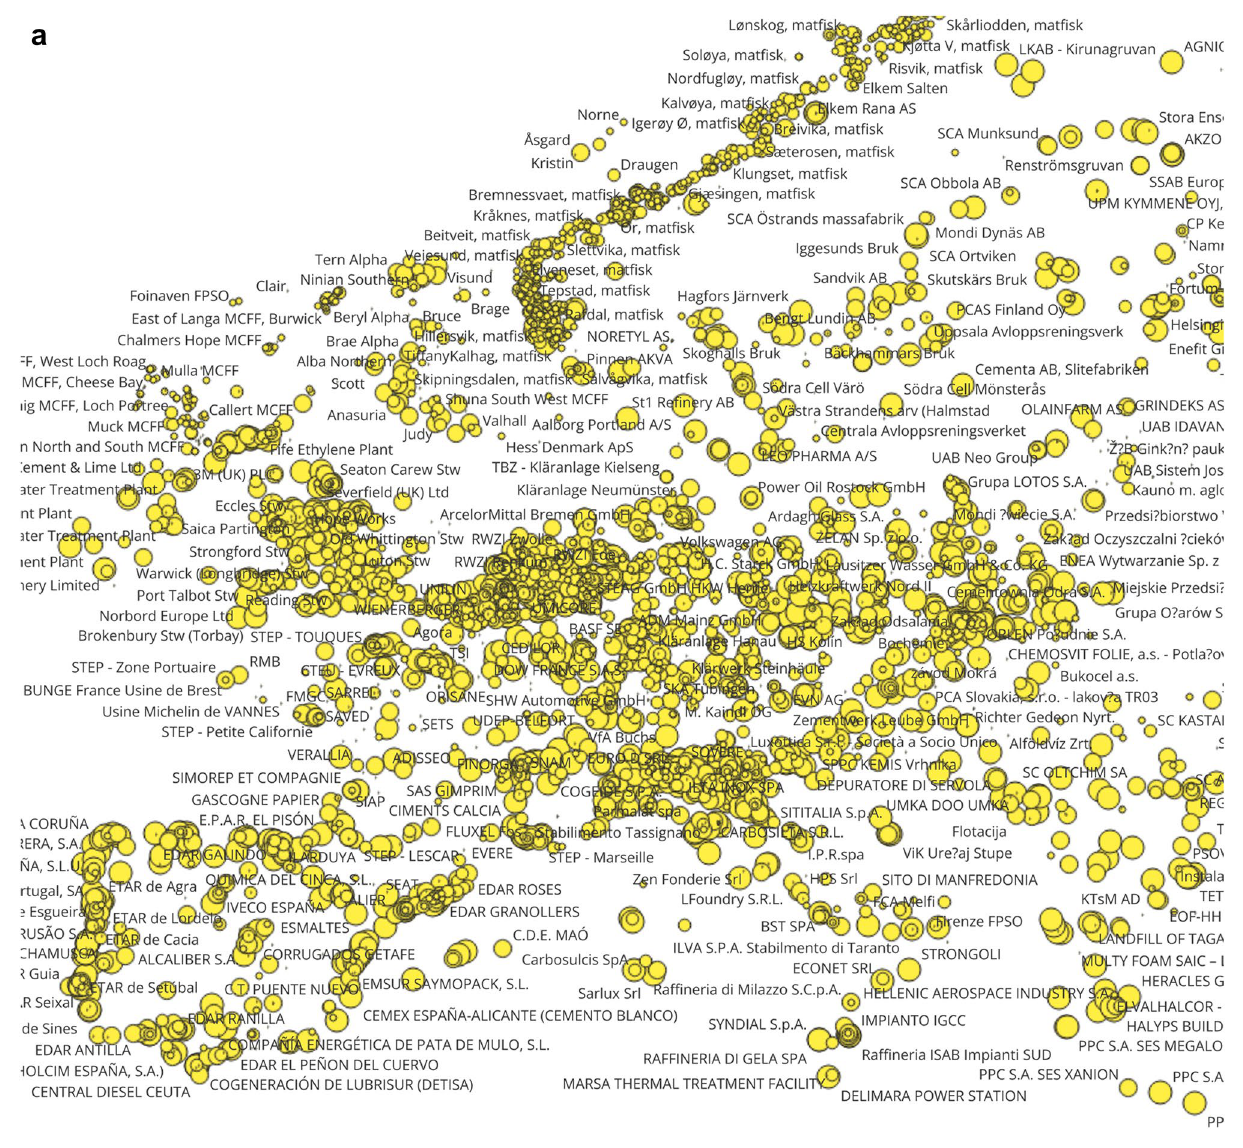
Figure 2. The human toxicity (CTUh, panel a ), ecotoxicity (CTUe, panel b ) and global warming ((CO2eq, panel c ) impact potentials of substances emitted from largest European point sources to air and water in 2017 characterized with USEtox 2.12 and IPCC values. Observations are visualized with QGIS 3.28, Firenze, (https:// qgis. org, 2022 version), and point-source releases are sized as a function of the toxicity and global warming impact potentials. Notes The outlier data point for Chromium compounds reported by Delimara Power station is corrected as suggested by the European Environmental Agency (693 kg instead of 69,300